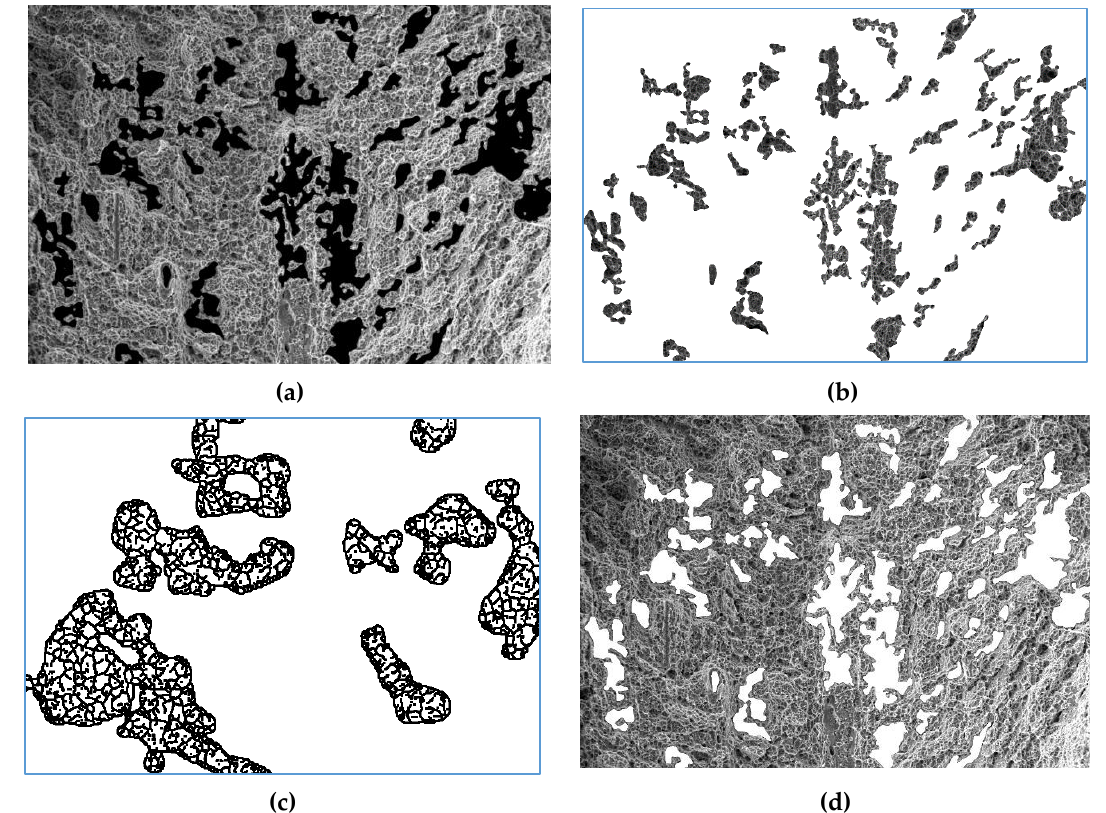
Figure 8. Fractogram of the fracture surface (Figure 2d) of specimens from alloy VT23M: Fractogram